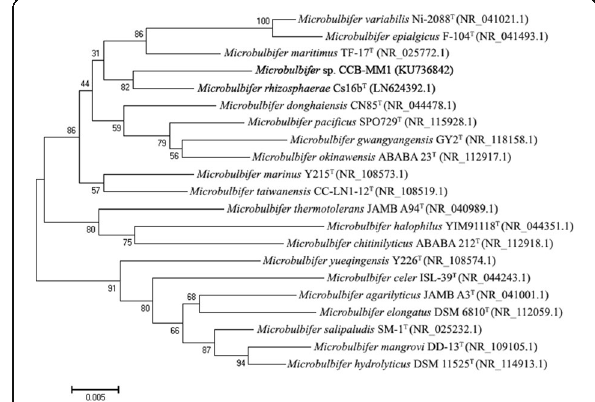
Fig. 2 Neighbor-joining phylogenetic tree highlighting the position of Microbulbifer sp. CCB-MM1 relative to other type strains within the genus Microbulbifer , built using MEGA6 based on 16S rRNA sequences with their GenBank accession numbers indicated in parentheses